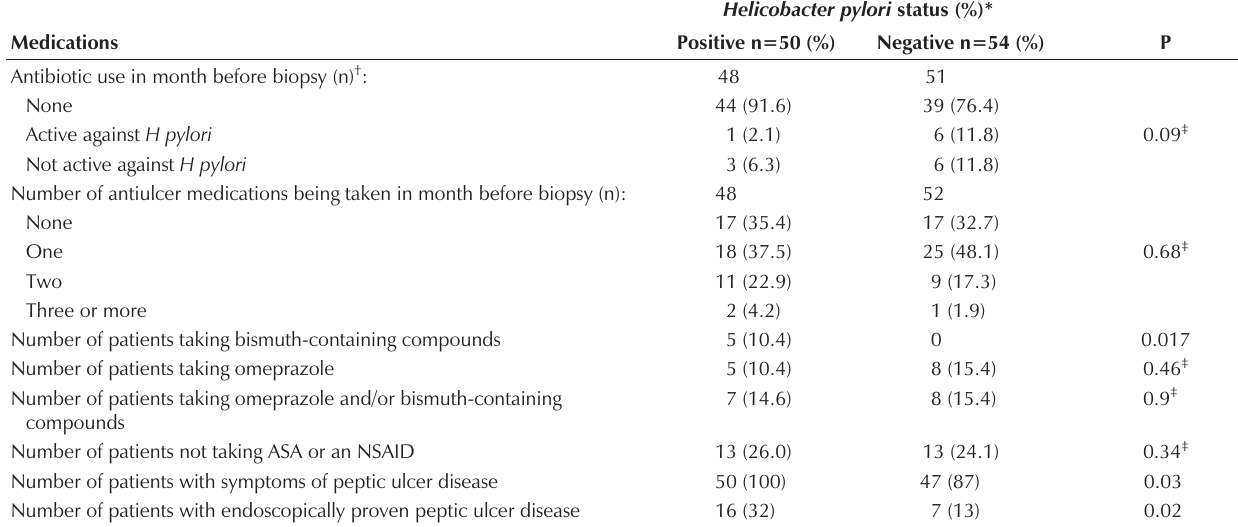
Medication use in the study population